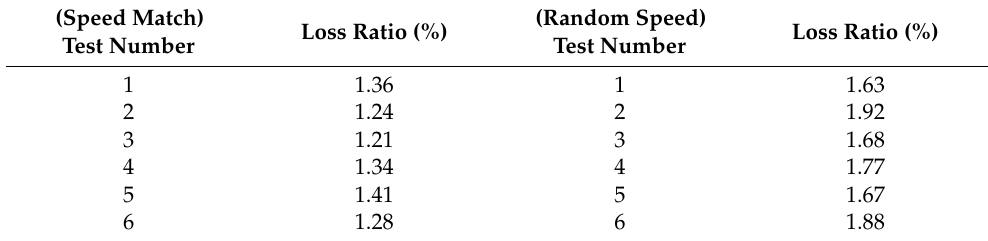
Table 7. The loss-rate table under matching rice rotation speed and the loss-rate table under random rotation speed and forward speed.